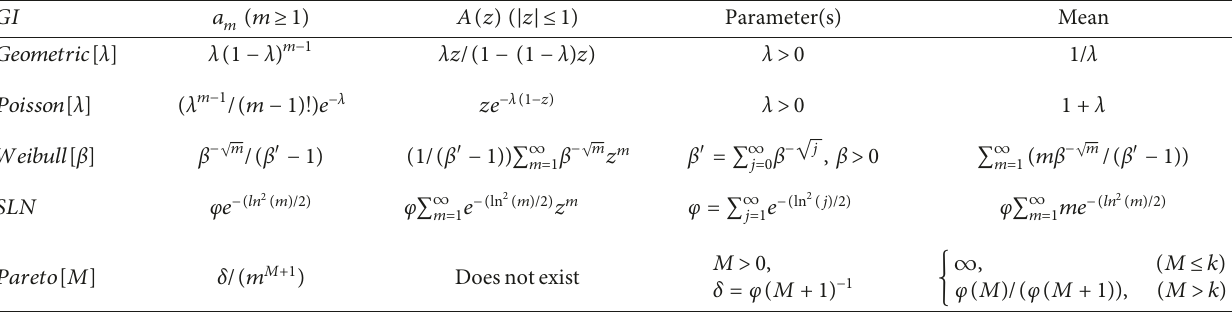
Table 1: Discrete probability distributions.